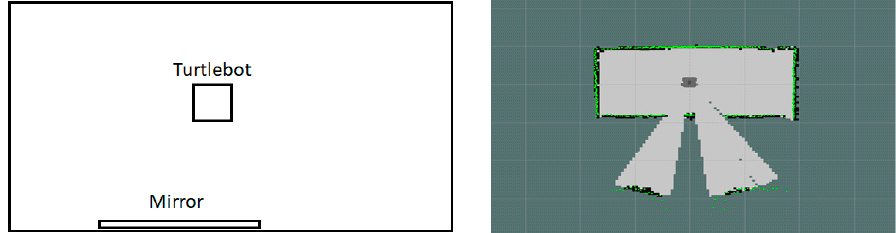
Figure 12. RViz map of tat positions (A–C) where the mobile robot is stationary in front of a plane mirror.